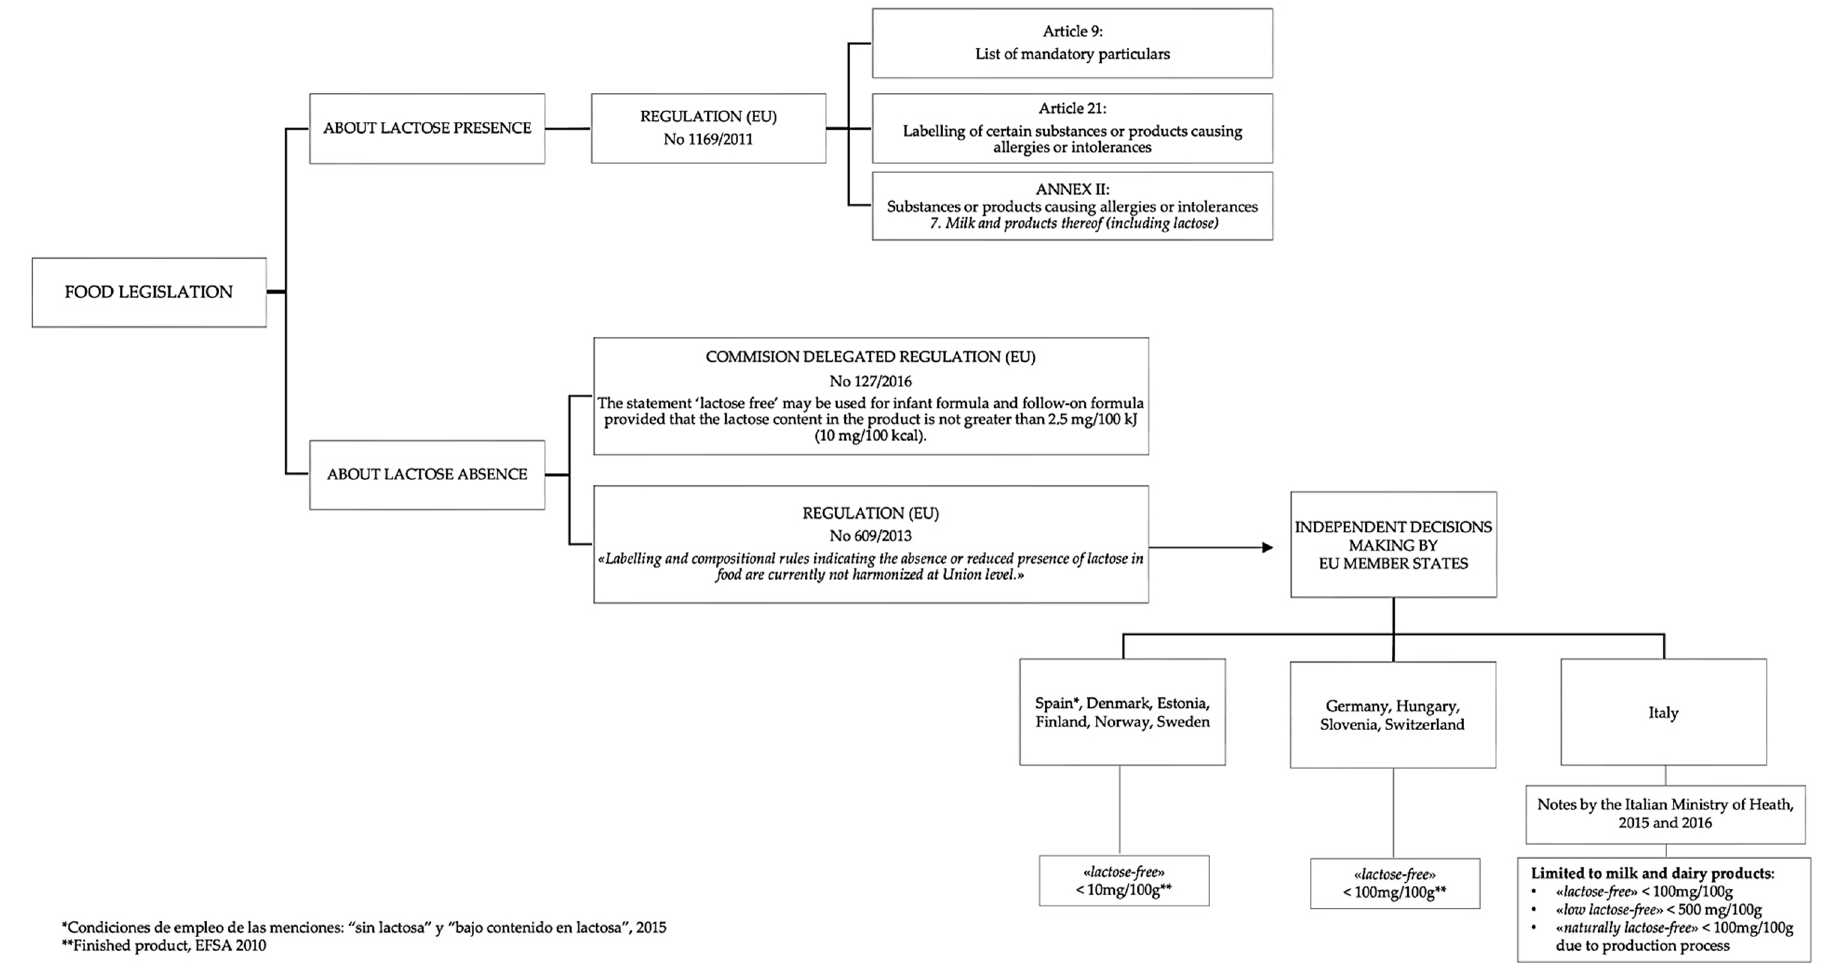
Figure 1. Overview of regulation about lactose in Europe [EFSA Panel on Dietetic Products, Nutrition and Allergies (NDA) [58,59].